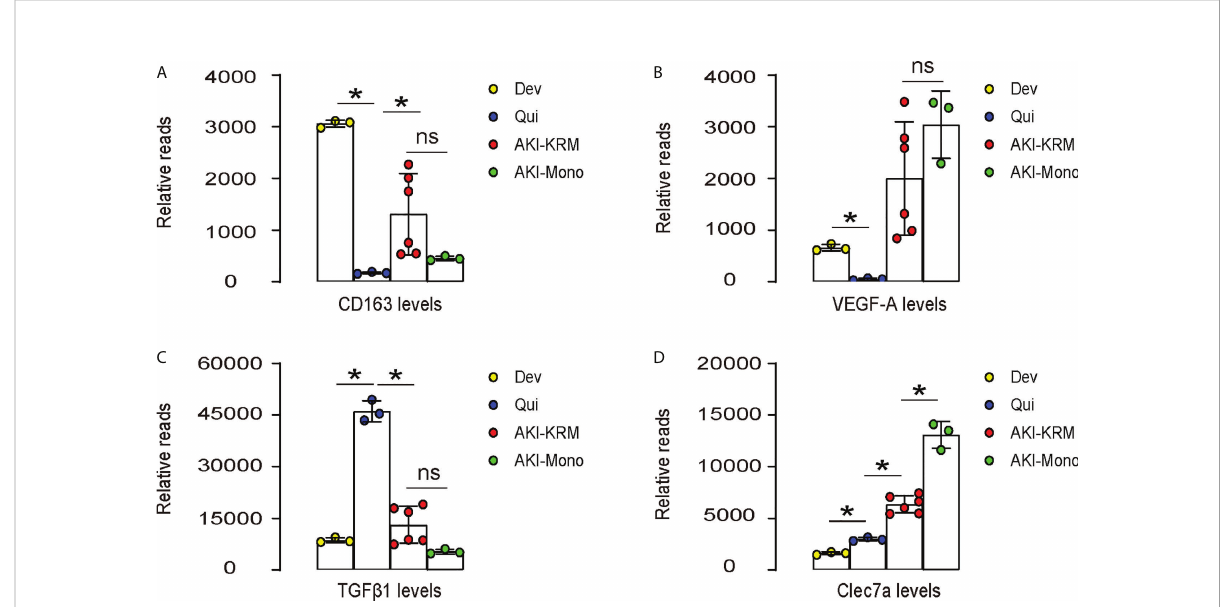
FIGURE 1 Bioinformatics show signi fi cant increases in Clec7a in renal macrophages after IRI-AKI. (A – D) Data were obtained from GEO database GSE121410, which recorded the analysis on mouse renal macrophages at development (Dev), quiescent status (Qui) and during AKI. AKI- macrophages were further separated as resident macrophages (AKI-KRM) and circulating monocytes -derived macrophages (AKI-mono). Transcript reads for CD163 (A) , VEGF-A (B) , TGF b 1 (C) and Clec7a (D) were shown. *p<0.05. ns, no signi fi